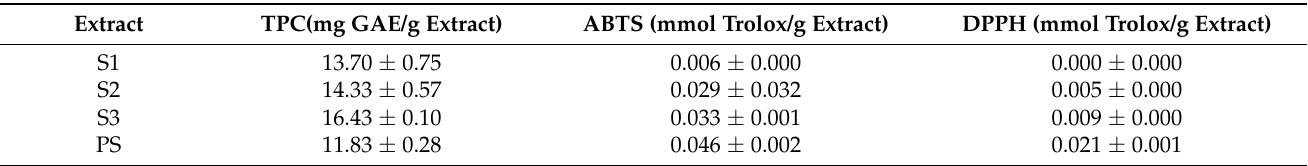
Table 2. Total phenolic content (TPC) and in vitro antioxidant activity of the SFE extracts from MB. Extract TPC(mg GAE/g Extract) ABTS (mmol Trolox/g Extract)